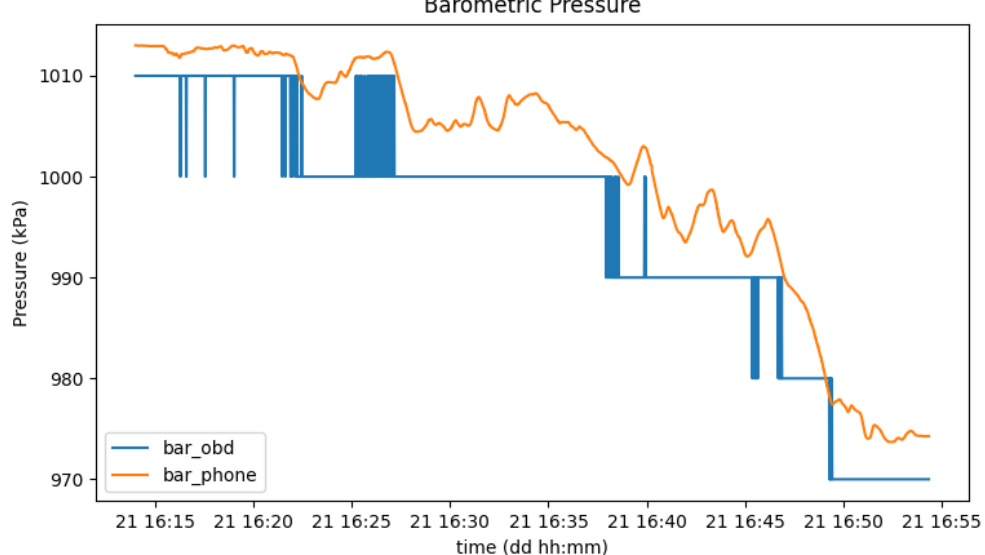
Figure 23. Barometric pressure measured from the OBD-II reader (blue) and the smartphone